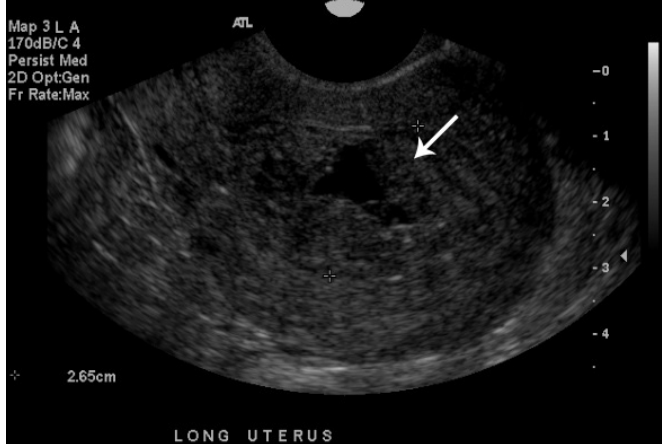
Figure 2 . Ultrasonography of uterus in transverse axis with color doppler flow showing pulsatile flow inside the endometrial